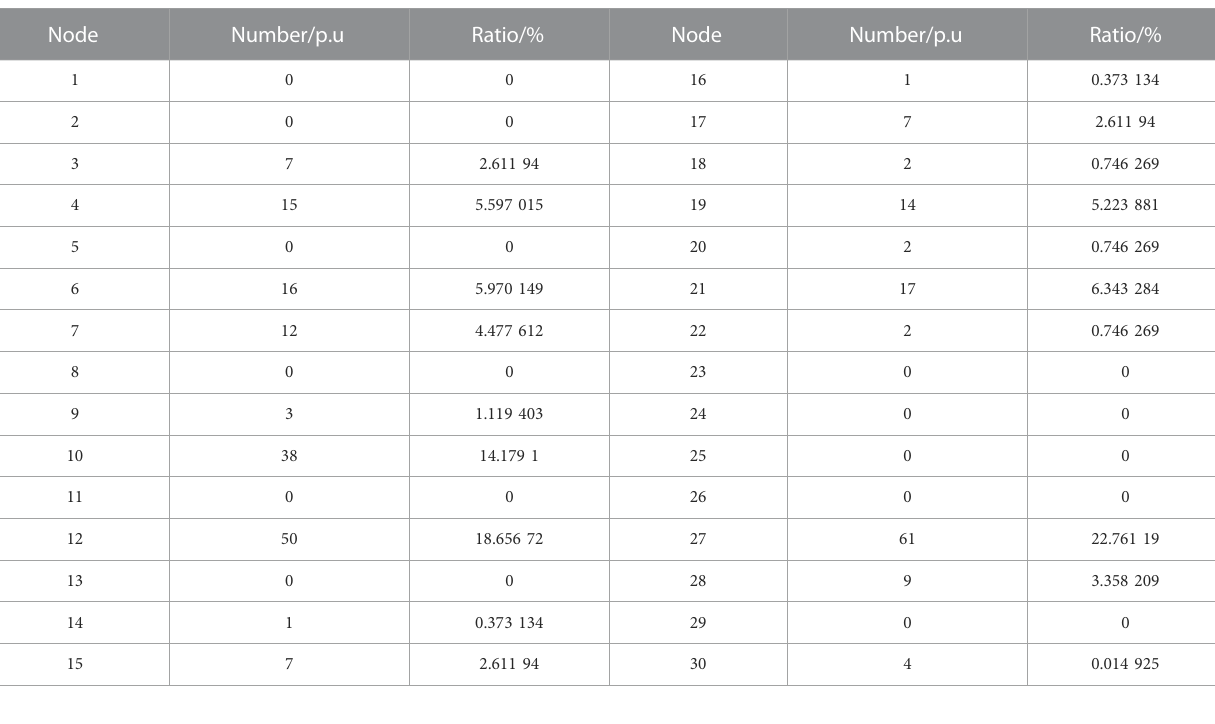
TABLE 12 Frequency and proportion of each node as the optimal node.